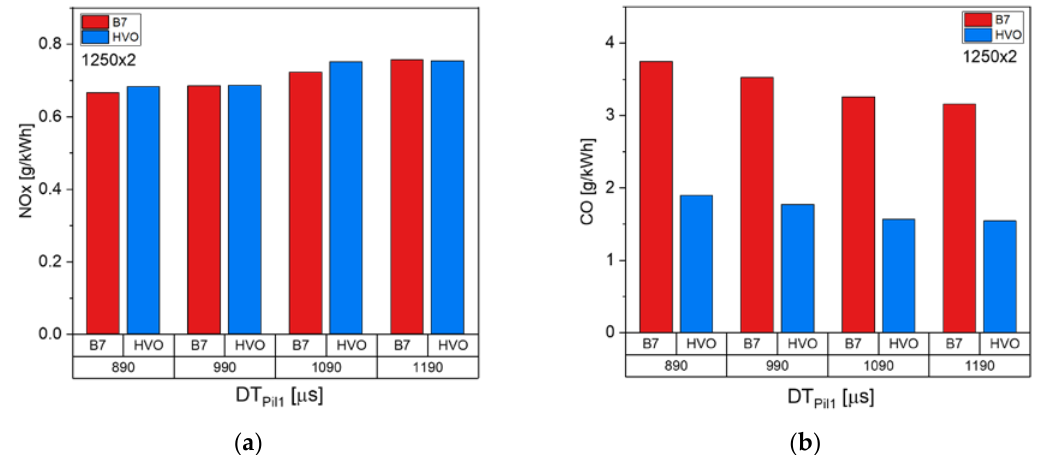
Figure 8. Influence of DT Pil1 on NO x ( a ) and CO ( b ) for diesel and HVO at 1250 × 2.